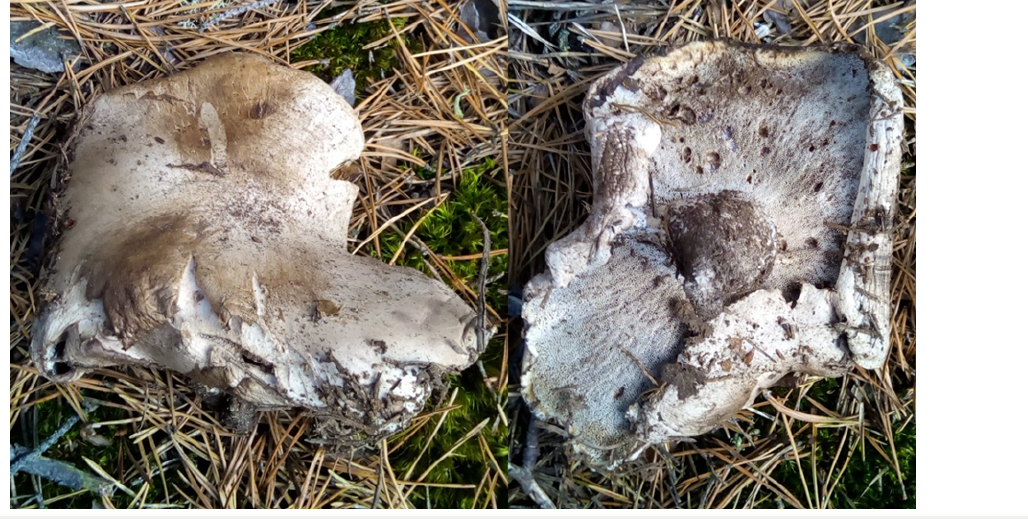
Figure 2 Boletopsis grisea , a species under strict legal protection in Poland.